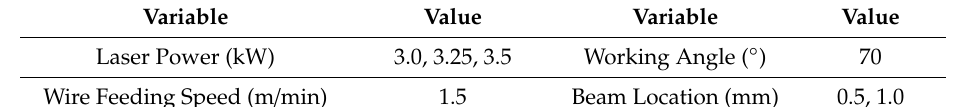
Table 9. Welding conditions of Step 2 (laser power change, beam location change, 6 cases).